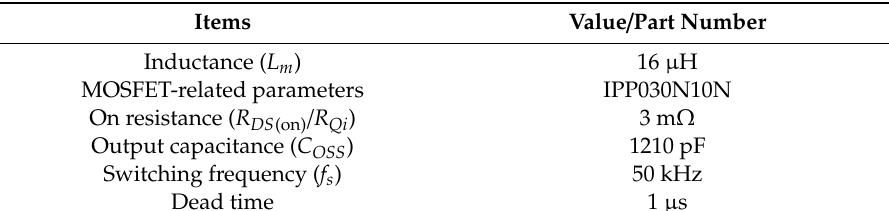
Table 2. Component parameters designed for the PCL unit.